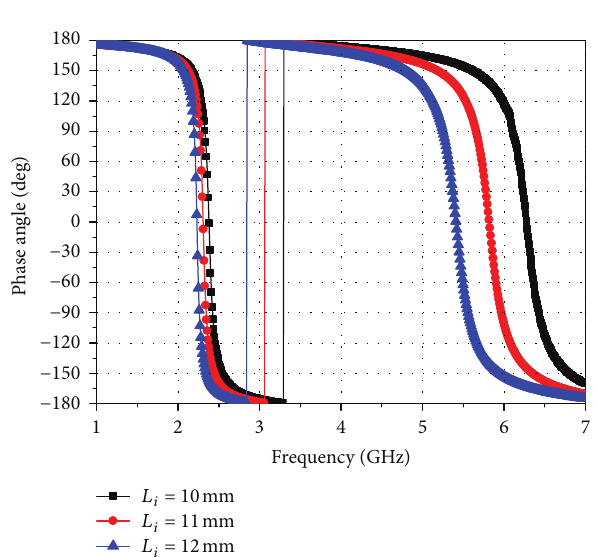
Figure 5: Effect of AMC parameter 𝐿 𝑖